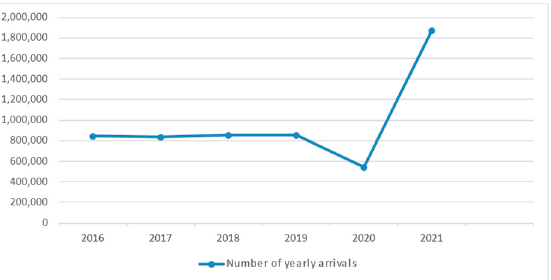
Figure 2. Number of yearly arrivals to Gargano National Park. Source: our elaboration based on data from Pugliapromozione (2021).